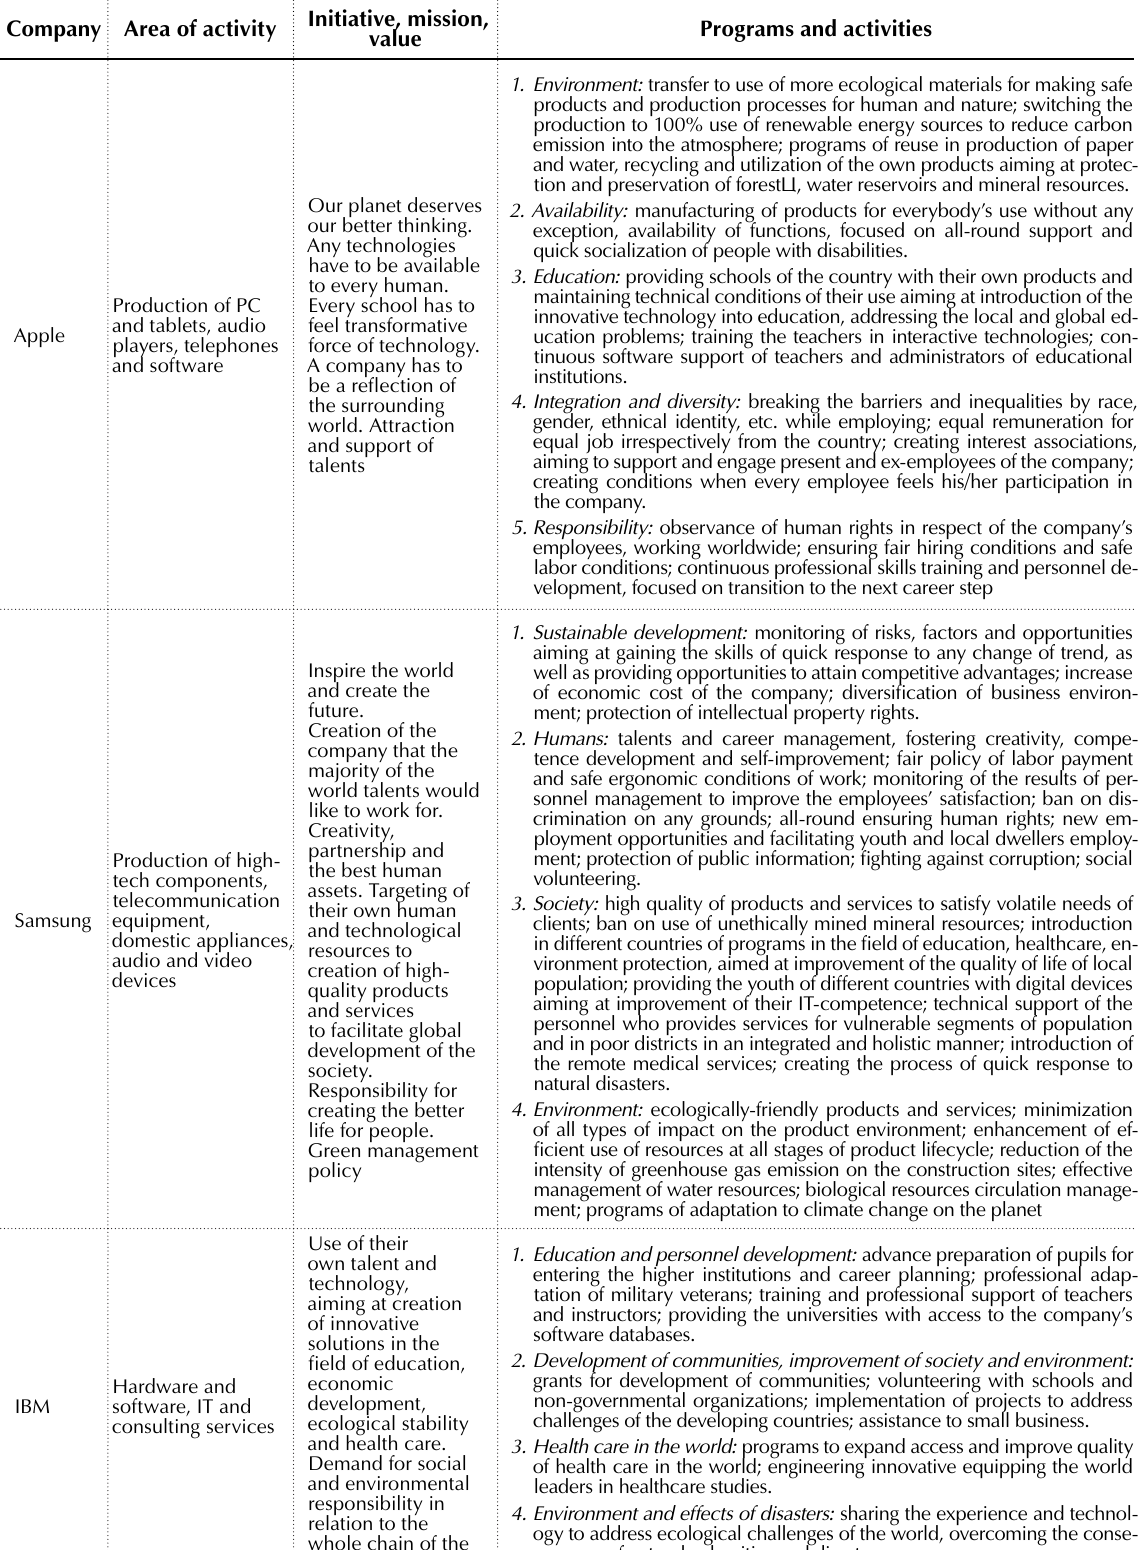
Table 1. Systematization of program initiatives of social responsibility of the companies, being innovative leaders of the